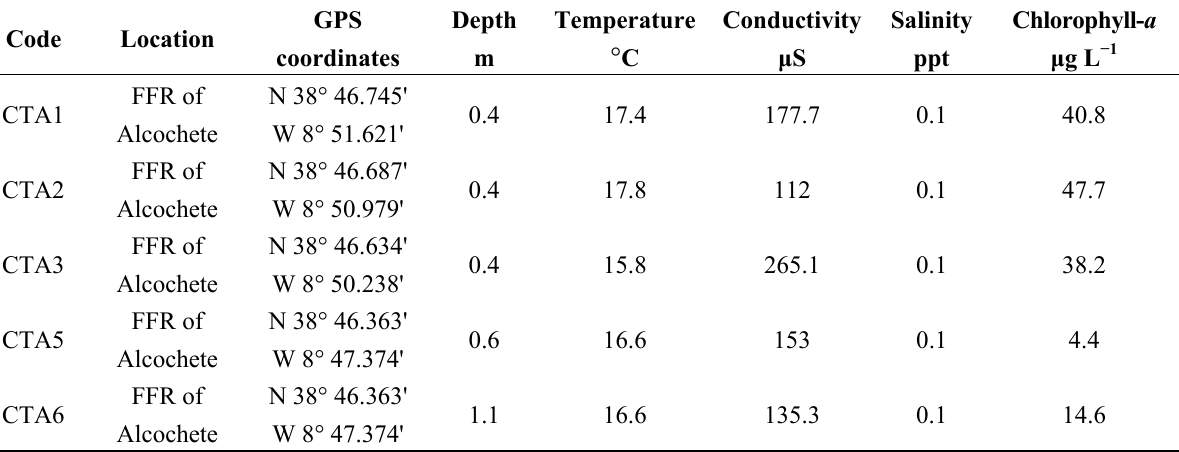
Table 2. Code, location, physical data and biomass of chlorophyll- a present in the sampling sites. FFR of Alcochete – Field Firing Range of Alcochete; PNSACV – Natural Park of the Southwest Alentejo and Vicentina Coast in